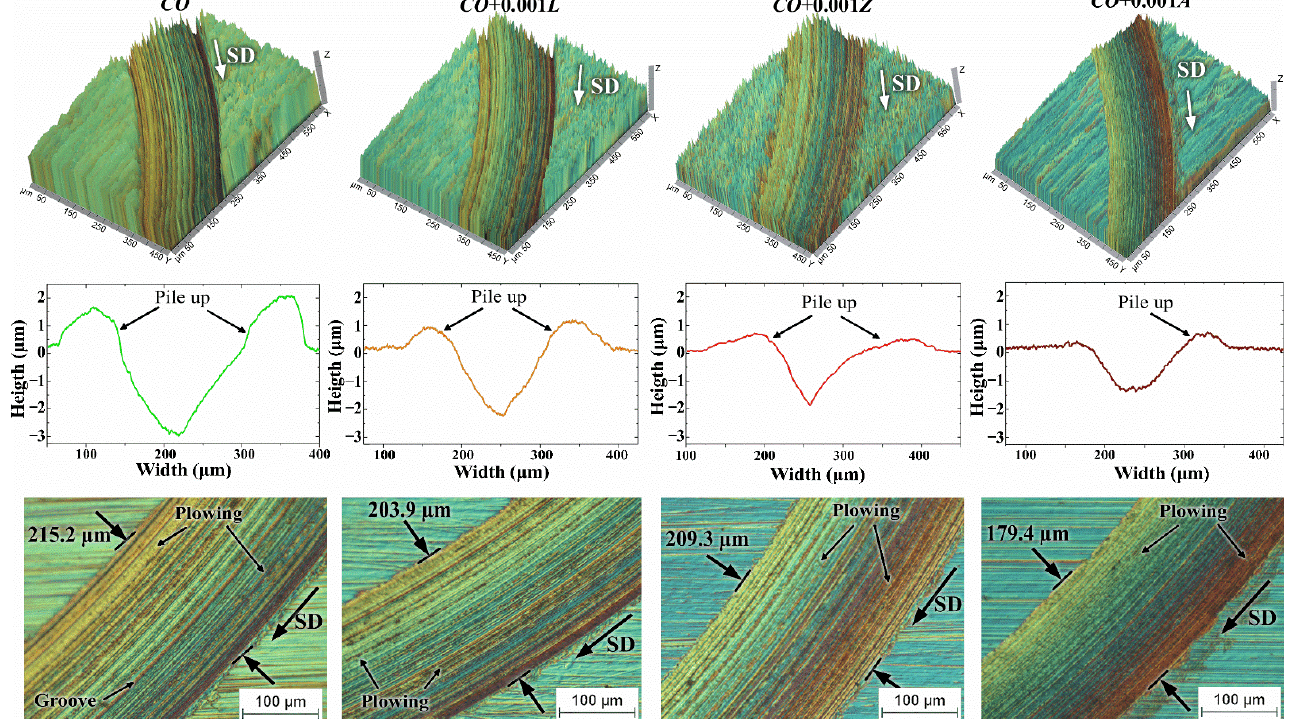
Figure 7. Effect of xanthophylls as additives in CO on the topography of worn surfaces and wear track width (micrographs at 200X). SD means sliding distance.